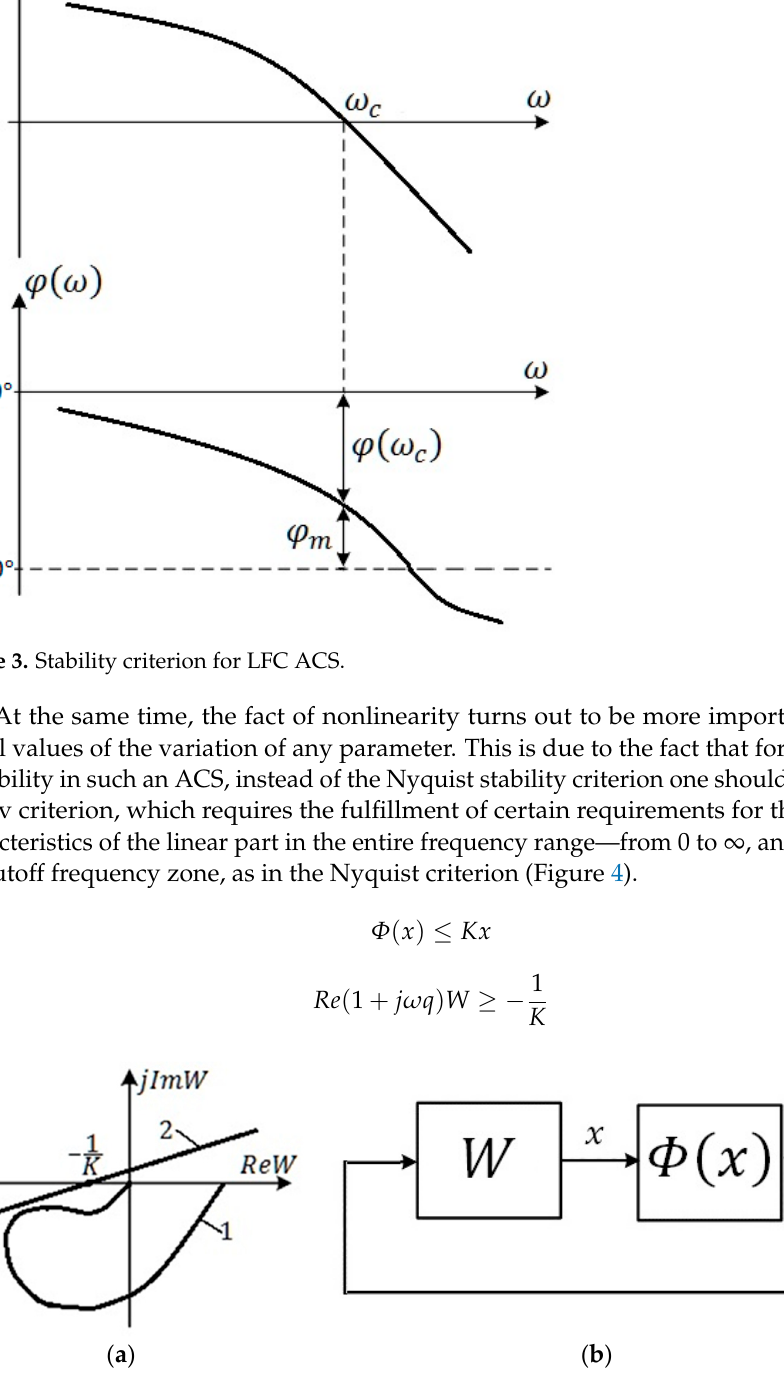
Figure 4. The V.M. Popov criterion, (5) and (6), demands the straight line “2” on frequency plane through critic point laid over hodograph “1” ( a ) of linear structure of ACS ( b ).